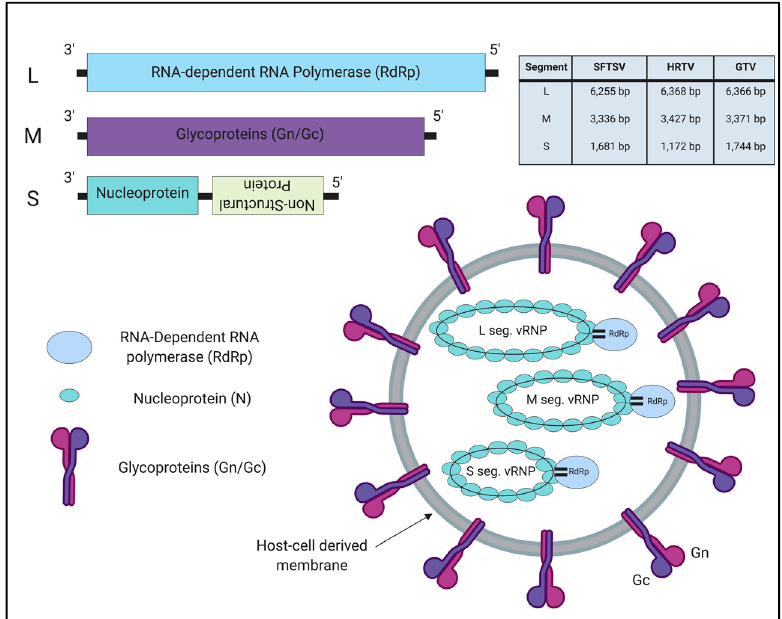
Figure 1. Genome organization and viral particle of tickborne banyangviruses. The tripartite segmented genome is comprised of three segments: Large (L), Medium (M), and Small (S). The L segment encodes the viral RNA ‐ dependent RNA polymerase. The M segment encodes two glycoproteins, Gn and Gc. The S segment is encoded in ambisense orientation and encodes the viral nucleoprotein (N) and the non ‐ structural protein (NSs), which is encoded in the opposite orientation to the N protein and therefore is written in upside down text. Viral particles measure 80 ‐ 100 nm in diameter for tickborne banyangviruses. The length of each segment for SFTSV, HRTV, and GTV is noted in the table.